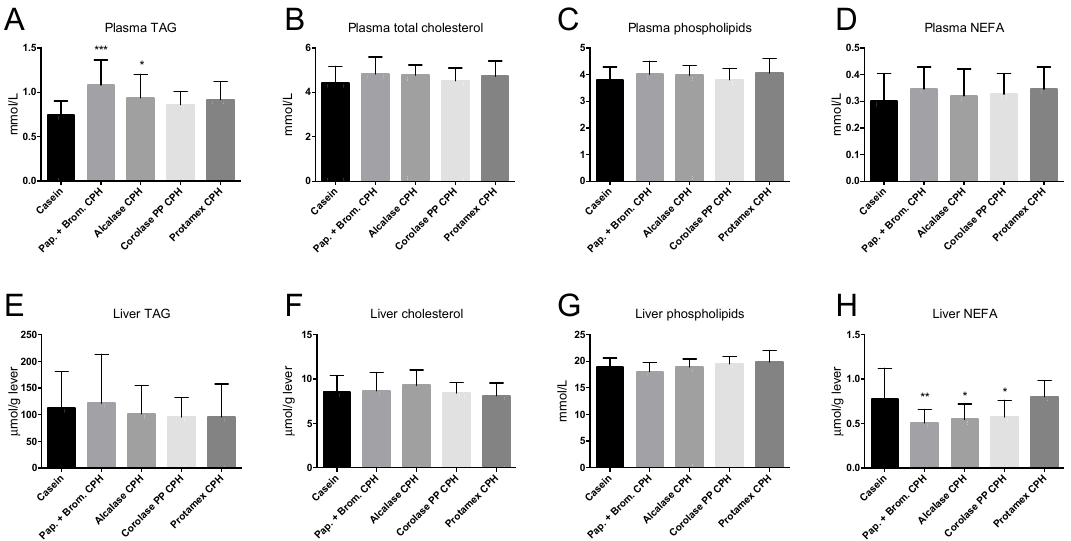
Figure 6. Plasma and liver lipid levels in C57BL/6 mice fed 19 E% casein- or 9.5 E% casein and 9.5 E% CPH-high fat/high sucrose diets for 12 weeks ( A ) Plasma triacylglycerol (TAG), ( B ), plasma total cholesterol, ( C ) plasma phospholipids, ( D ) plasma non-esterified fatty acids (NEFA), ( E ) liver TAG, ( F ) liver cholesterol, ( G ) liver phospholipids, ( H ) liver NEFA. Values are means with standard deviation ( n = 11–12). Significant differences between values were determined by one-way ANOVA with Fisher’s LSD test (* p < 0.05, ** p < 0.01, *** p < 0.001).